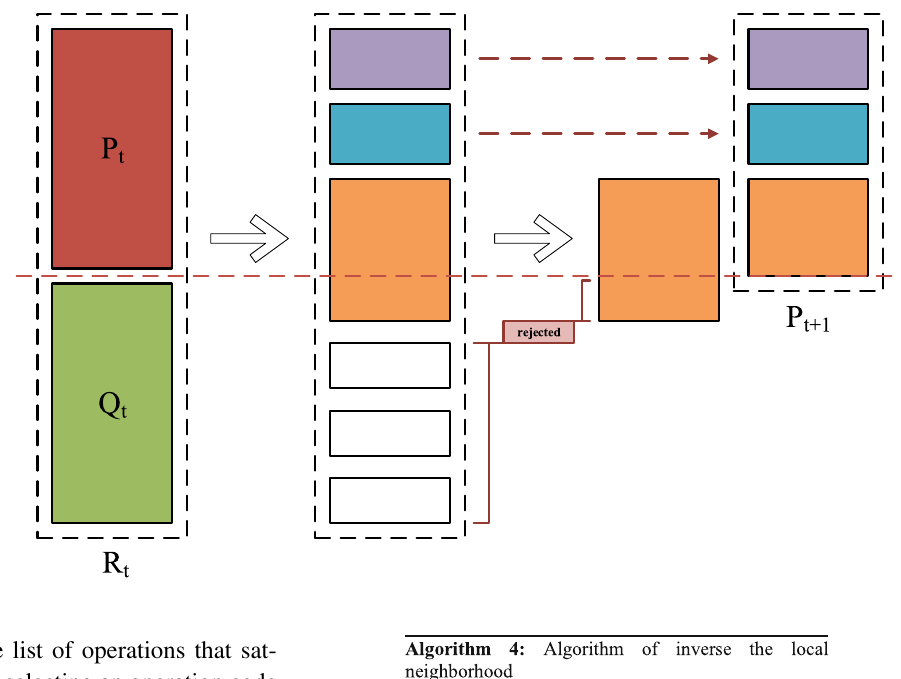
Fig. 5 Elitism of